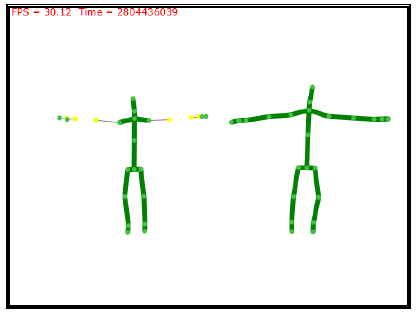
Figure 16. Couples recordings in Kinect Studio